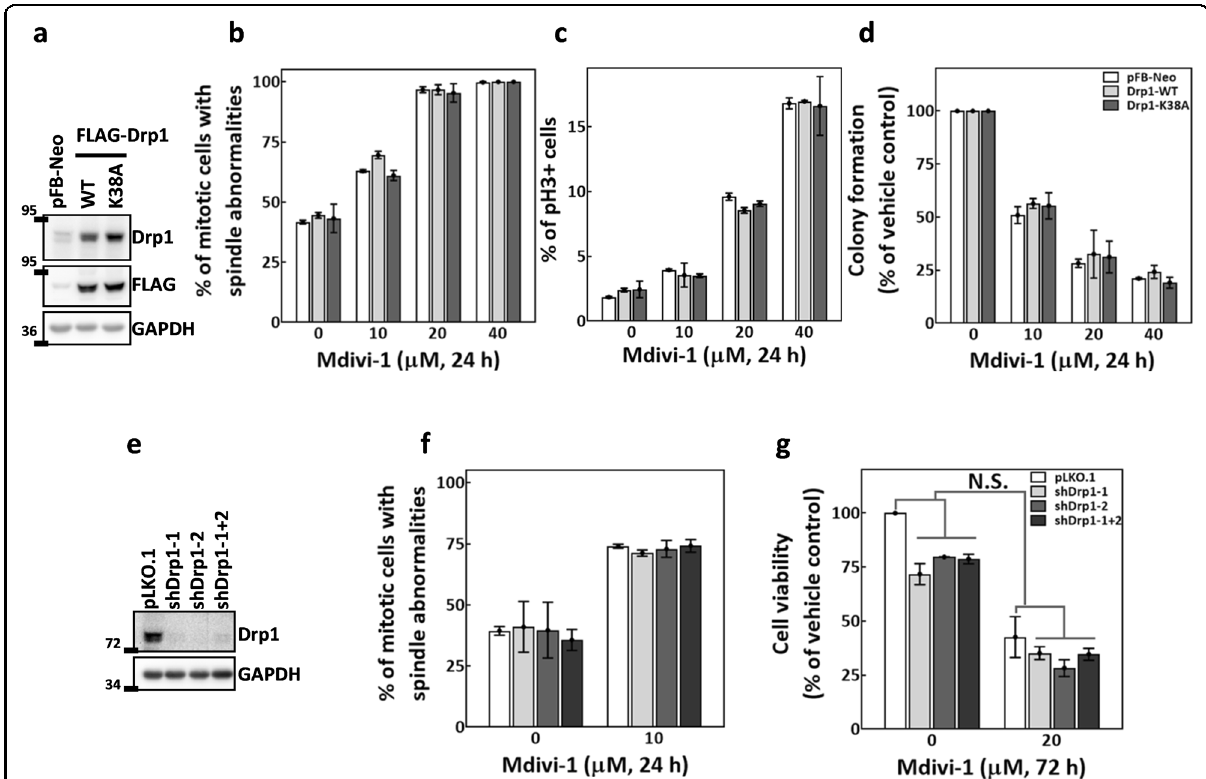
Fig. 3 Mdivi-1 induces mitotic abnormalities independent of Drp1. a Western blot shows the overexpression ef fi ciency of FLAG-Drp1-WT and -K38A. b – d Overexpression of Drp1 did not affect the antimitotic effects of mdivi-1. MDA-MB-231 cells harboring empty vector (pFB-Neo) or overexpressing wild-type (Drp1-WT) or dominant-negative mutant (Drp1-K38A) Drp1 were treated with indicated concentrations of mdivi-1 for 24 h and then subjected to analysis of spindle abnormalities ( b ), mitotic arrest ( c ), and colony formation ability ( d ). Data are presented as mean ± SD from three independent experiments. e Western blot shows the depletion ef fi ciency of shRNA targeting Drp1. f and g Depletion of Drp1 did not affect the antimitotic effects of mdivi-1. MDA-MB-231 cells depleted of Drp1 were treated with the indicated concentrations of mdivi-1 for 24 h and then subjected to analysis of spindle abnormalities ( f ) or cells were treated for 72 h and then subjected to trypan blue exclusion assay for viability analysis ( g ). Data presented are mean ± SD from three independent experiments. N.S. no signi fi cance comparing 20 μ M mdivi-1 to no mdivi-1 by two- way